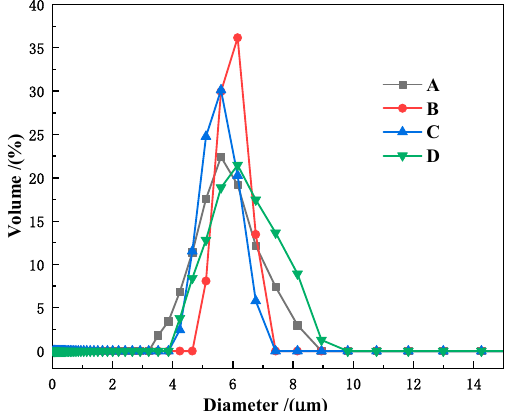
Figure 2. Pore size distribution curves of the four P(MAA/St) microspheres with different ratios of St and MAA: P-1 ( A ); P-2 ( B ); P-3 ( C ); P-4 ( D ).